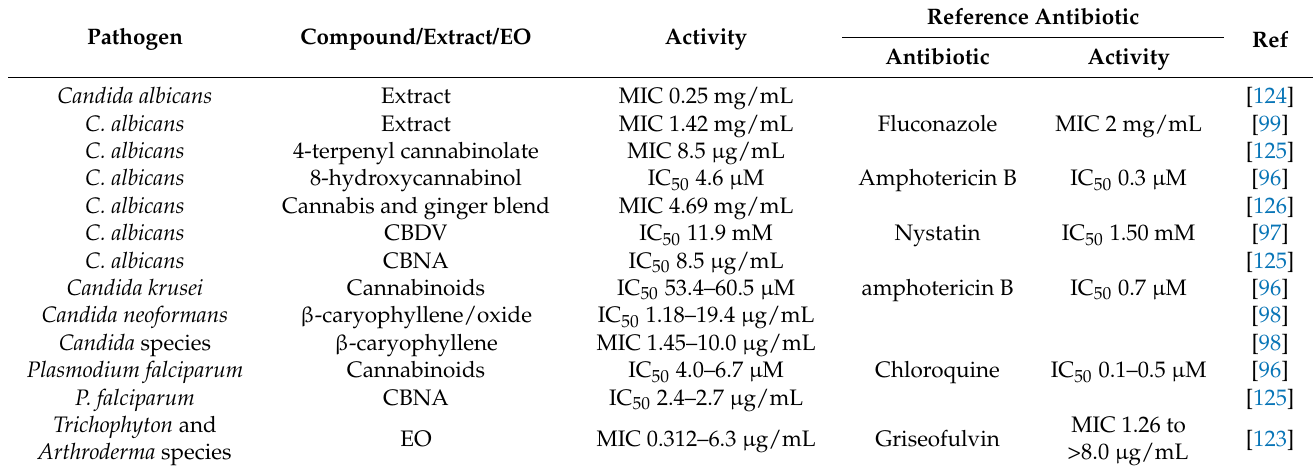
Table 3. Activity of cannabinoids and C. sativa against fungi.